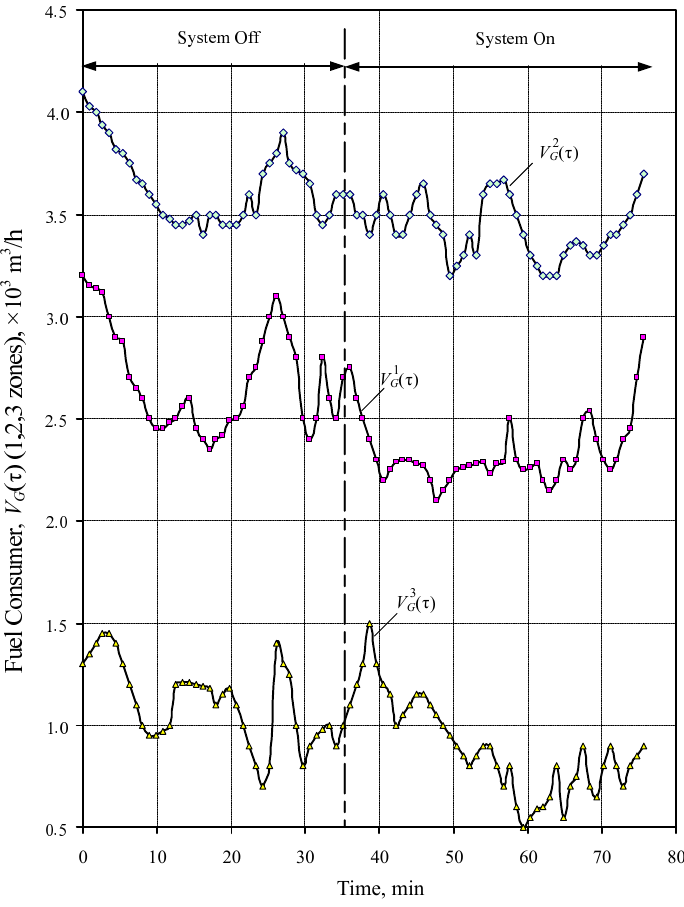
Figure 6. Mixed-gas flow rate curves, Zones 1–3, Furnace No. 4, Mill 2500: optimal heating control system on and off.